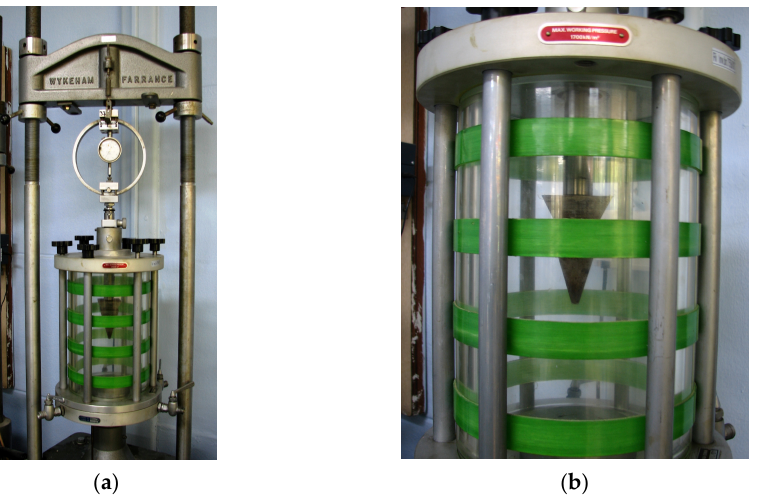
Figure 14. Modified triaxial test equipment for underwater coal mining cutting resistance testing: ( a ) modified triaxial test equipment, ( b ) testing wedge position.